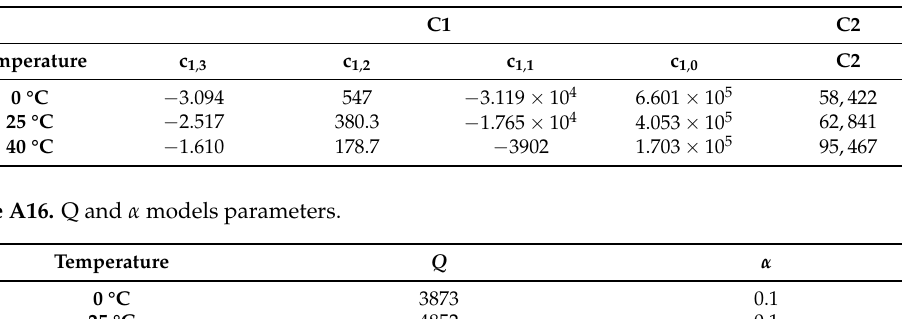
Table A15. C1 and C2 models parameters.